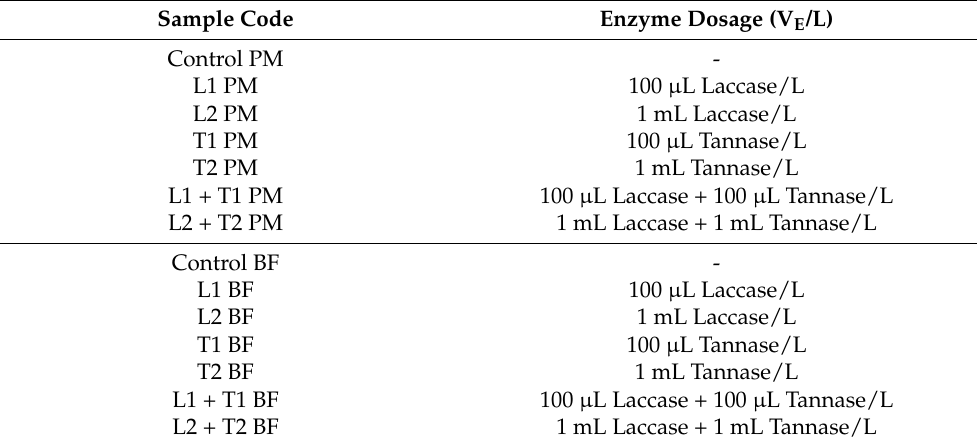
Table 1. Experimental design: treatment groups. Sample